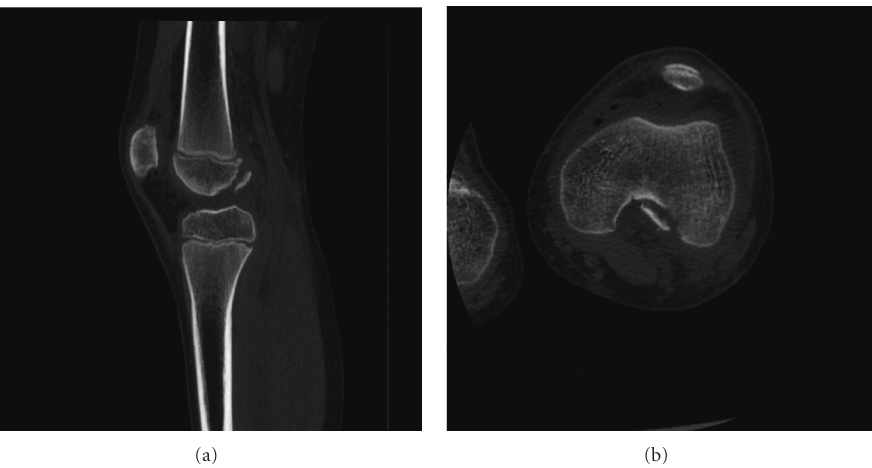
Figure 3: CT scan depicting (a) sagittal and (b) axial views of the patients knee depicting the avulsed osteochondral fragment.